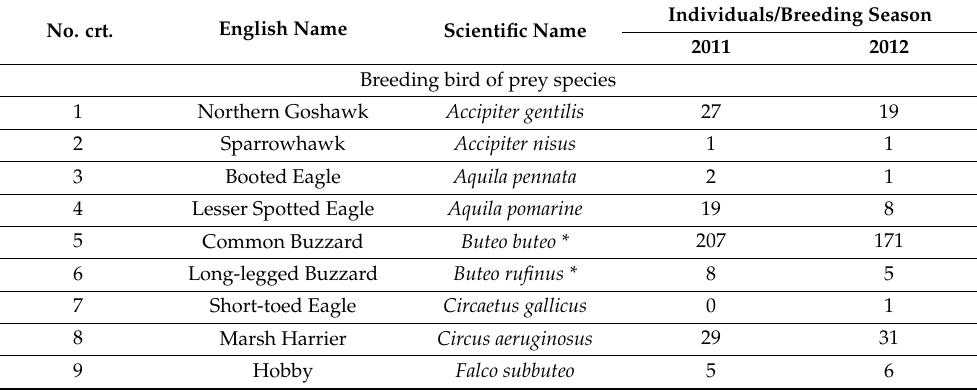
Table A1. The total number of birds of prey and owl species recorded during 2011 and 2012 breeding seasons in eastern